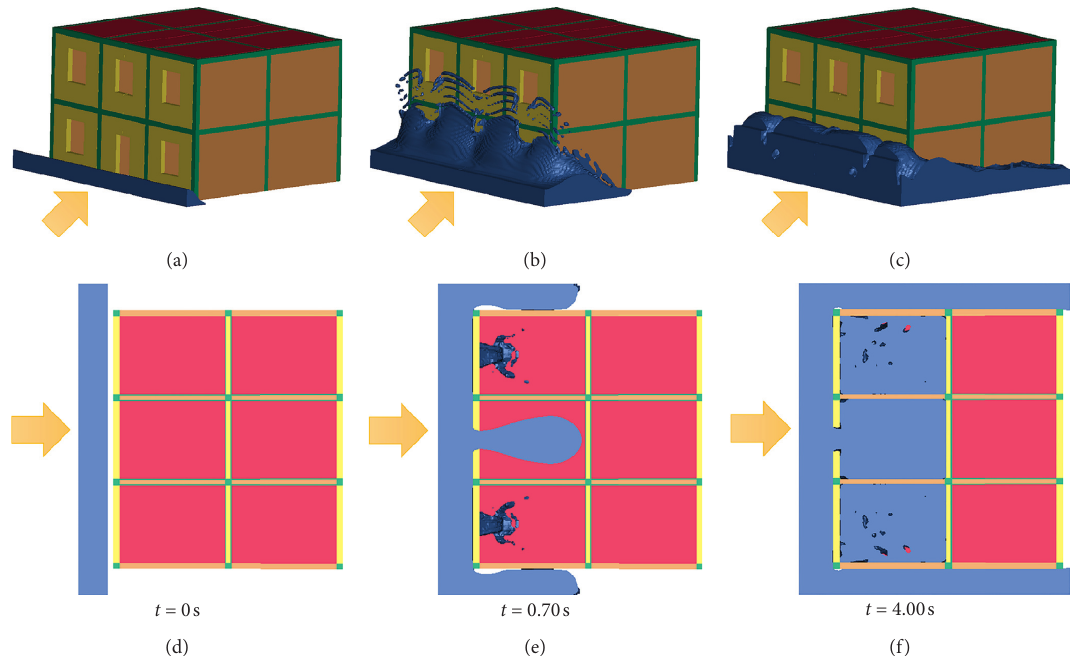
Figure 5: Snapshots in the scenario of s � 0, h � 0.8m, and v � 4.0m/s: (a–c) oblique view, and (d–f) bottom view.